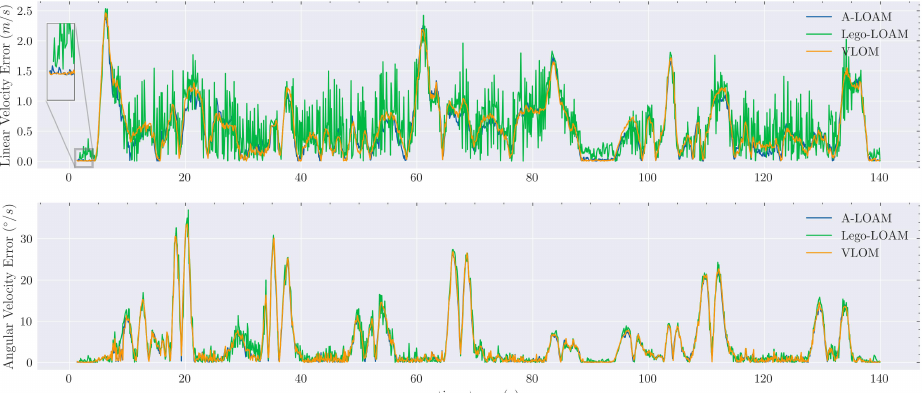
Figure 15. Comparison of velocity errors on the OS dataset, including the linear velocity error ( top ) and angular velocity error ( bottom ).